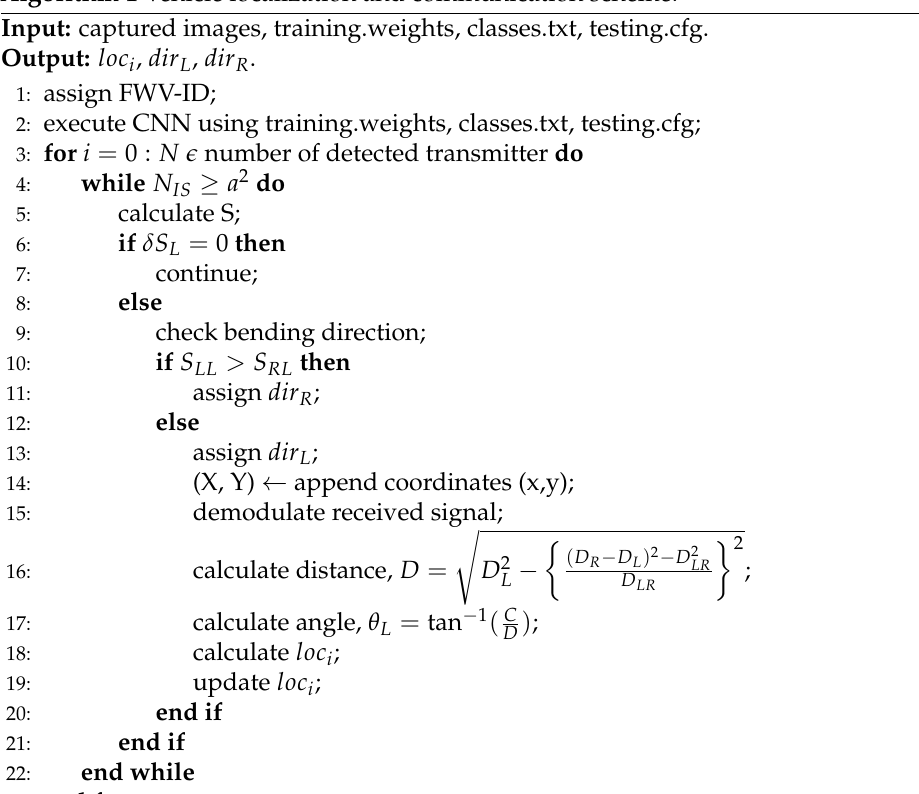
Algorithm 1 Vehicle localization and communication